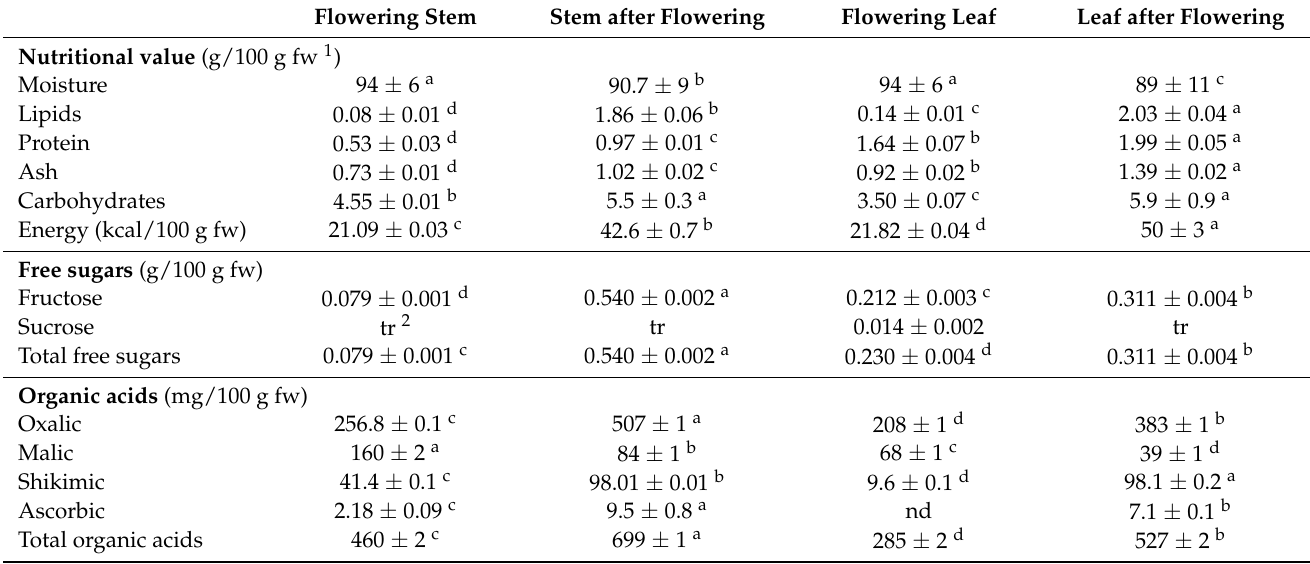
parts (mean ± SD, n =